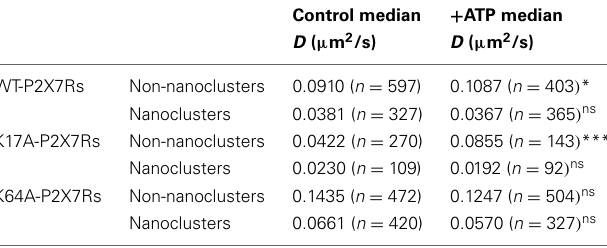
Table 1 | (Supporting Figure 5) Median diffusion coefficient ( µ m 2 /s) and number of trajectories ( > 10 points) used for diffusion